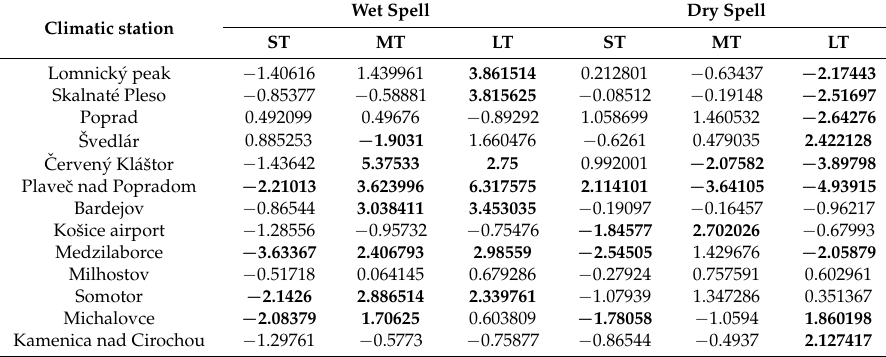
Table 7. Values of Z statistics of the MK test at 95% confidence level for wet/dry spells. Wet Spell Climatic